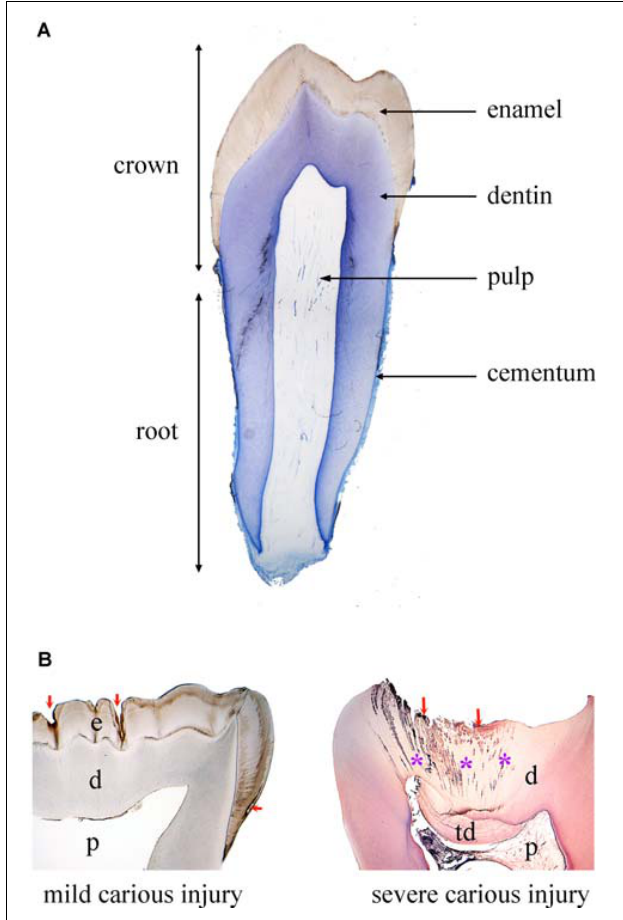
FIGURE 1 | Tooth structure in physiological and pathological conditions. (A) Histological section of a human premolar (blue color: toluidine blue). (B) Histological sections of human carious teeth. Left side: ground unstained section, showing mild carious injuries (red arrows) affecting only enamel. Right side: decalcified section stained with hematoxylin and eosin, showing a severe carious injury (red arrows) with bacterial invasion (asterisks: bacterial front within dentin). Abbreviations: d, dentin; e, enamel; p, pulp; td, tertiary